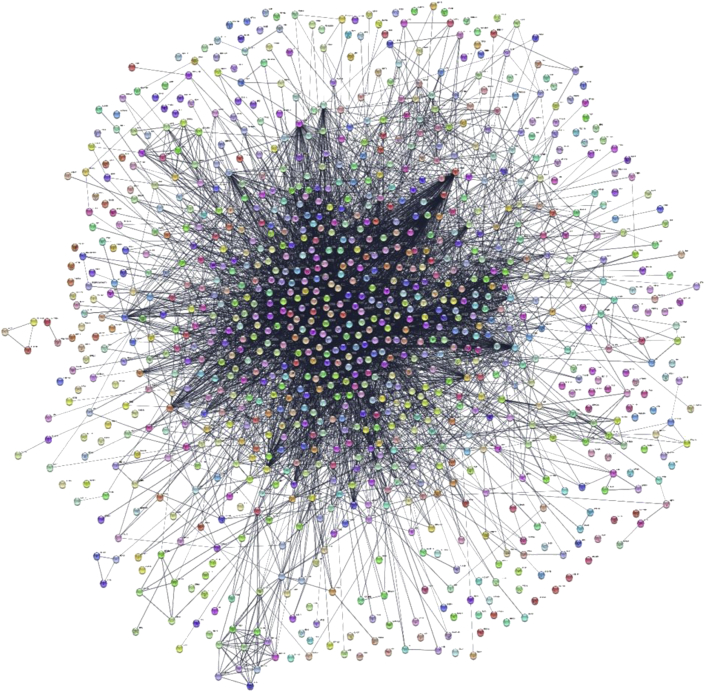
PD-associated PPI (PD-PPI) network generated with the STRING app of Cytoscape. The network includes 1000 nodes and 6851 edges.